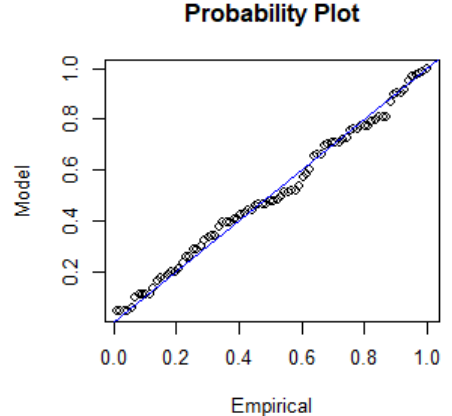
Figure 8. Extreme samples extracted by the peak over threshold (POT) method at location S1.